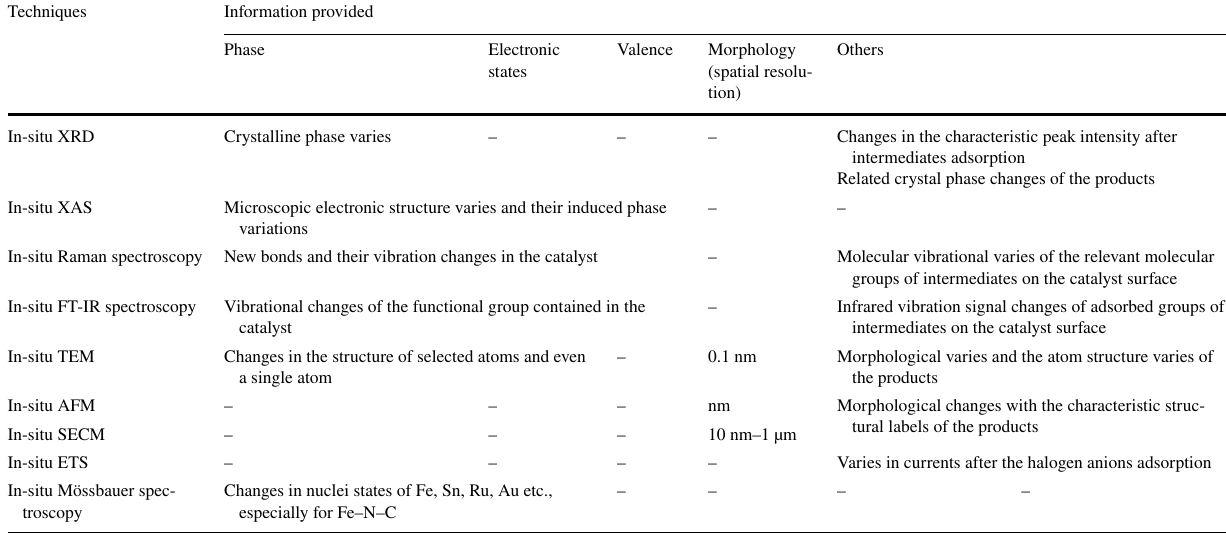
Table 2 Capabilities of different in-situ techniques for probing the essential information to identify actives sites and reveal the ORR mechanism